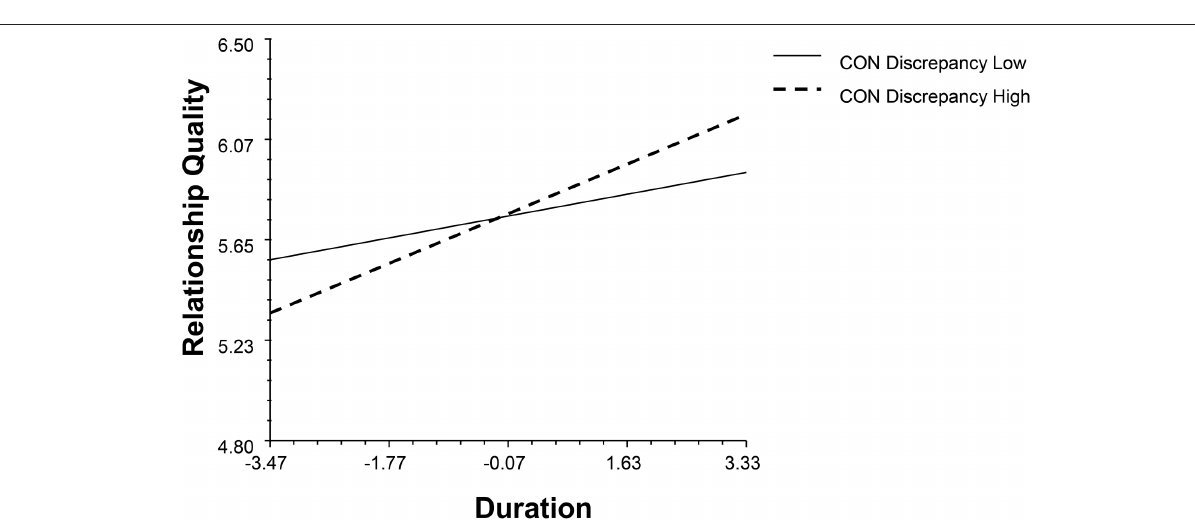
FIGURE 6 | The interaction between conscientiousness discrepancy and